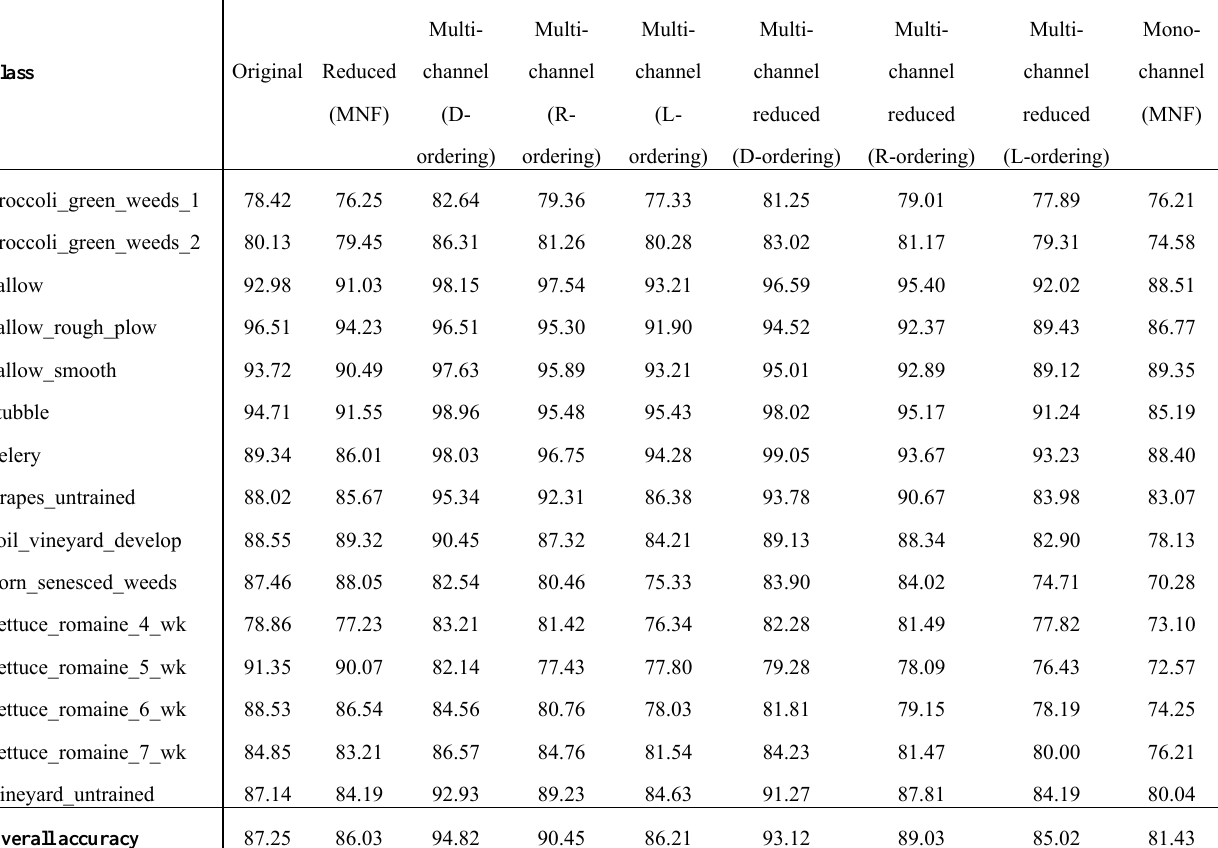
Table 2. Overall and individual test classification accuracies (in percentage) obtained after applying the proposed SVM classification system (with Gaussian kernel), using mono- channel and multi-channel morphological profiles with 9  k opening/closing operations, to the Salinas AVIRIS scene with 190 spectral bands. Results using the original spectral information and an MNF-based reduced version of the original scene (obtained after retaining the first 22  p components) are also